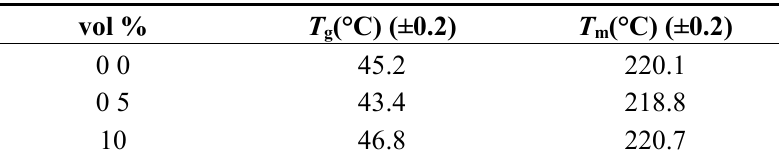
Table 3. Glass transition ( T g ) and melting temperatures ( T m ) of master batches with different NP volume fractions (vol